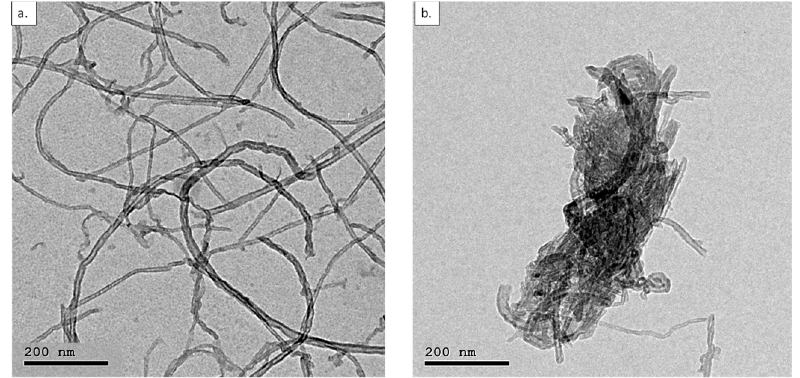
Figure 2. TEM images of ( a ) Eli-0 and ( b ) Eli-400 CNTs at 200 nm scale.